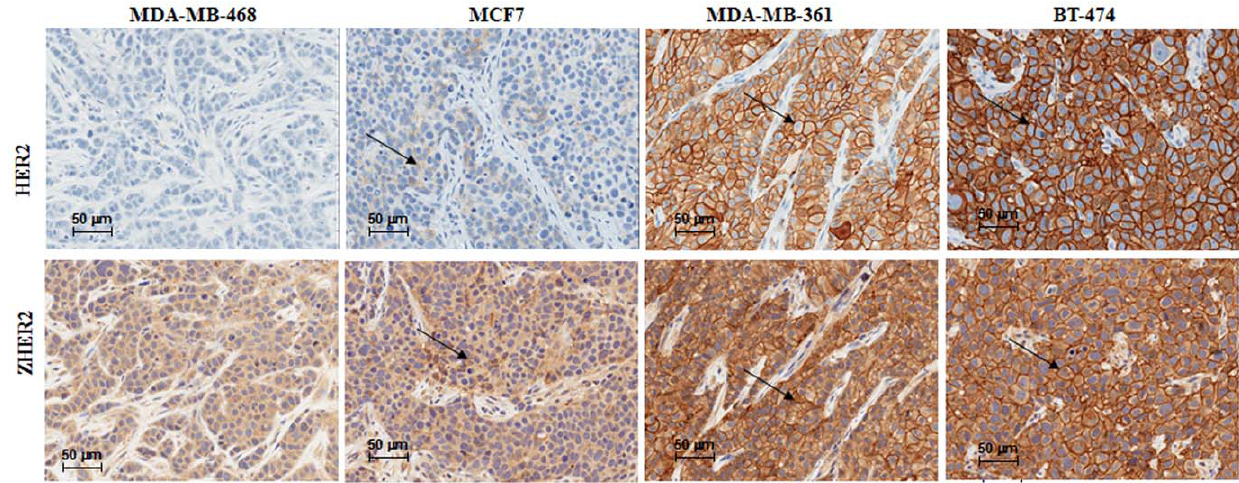
Figure 6. IHC analysis of tumor tissue extracted from four different breast tumor models 24 hours post Z HER2 -DyLight-750 injection. Tumor tissues were extracted from animals 24 hours post probe injection, fixed in 10%NBF and analyzed by IHC. Adjacent sections were stained for detection of HER2 (upper panel) and Affibody as described in Material and Methods section. Arrows point positively stained cell membranes in the tumor tissue. doi:10.1371/journal.pone.0041016.g006 indicate a good linear correlation between both parameters over the broad range of HER2 overexpression in cancer cells.